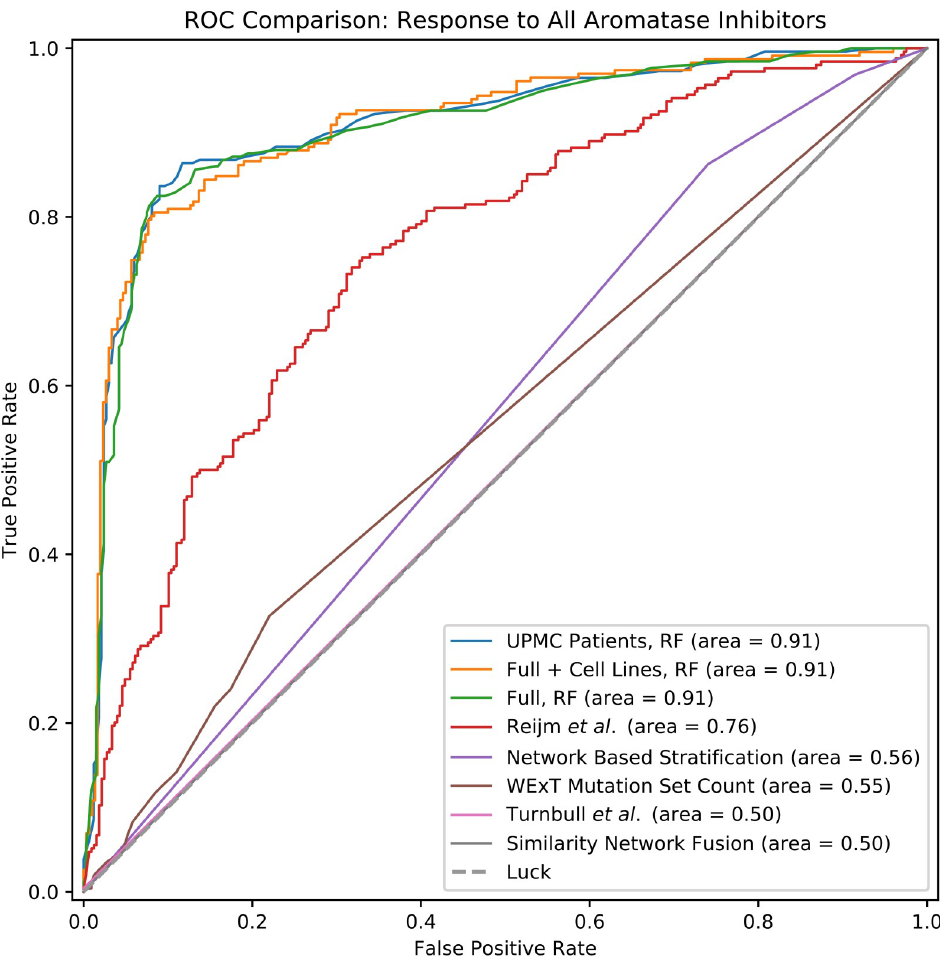
Fig 5. Performance comparison between multiple prediction strategies, for prediction of aromatase inhibitor non-